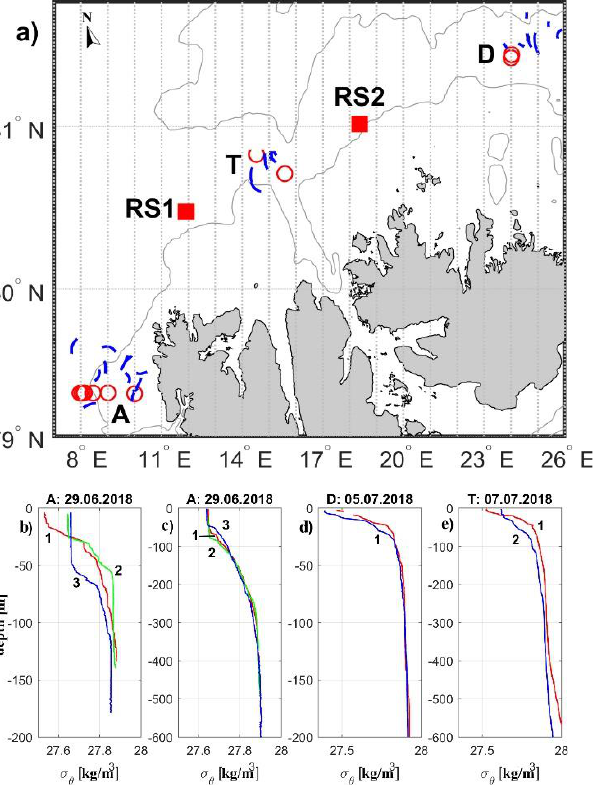
Figure 5 . Comparison of satellite SIW observations with in situ measurements made near Svalbard in June-July 2018: a) locations of stations along sections A-T (red circles) and leading waves of SIW trains observed nearby (blue lines). b)-d) vertical profiles of potential density at selected stations made along sections A-T.